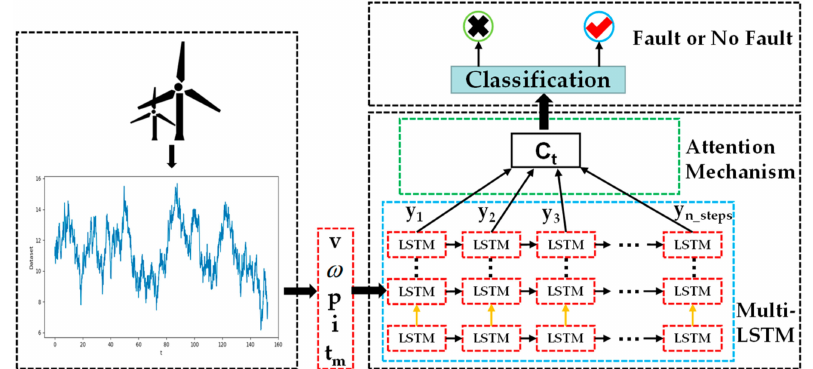
Figure 4. The overall structure of the imbalance fault detection.